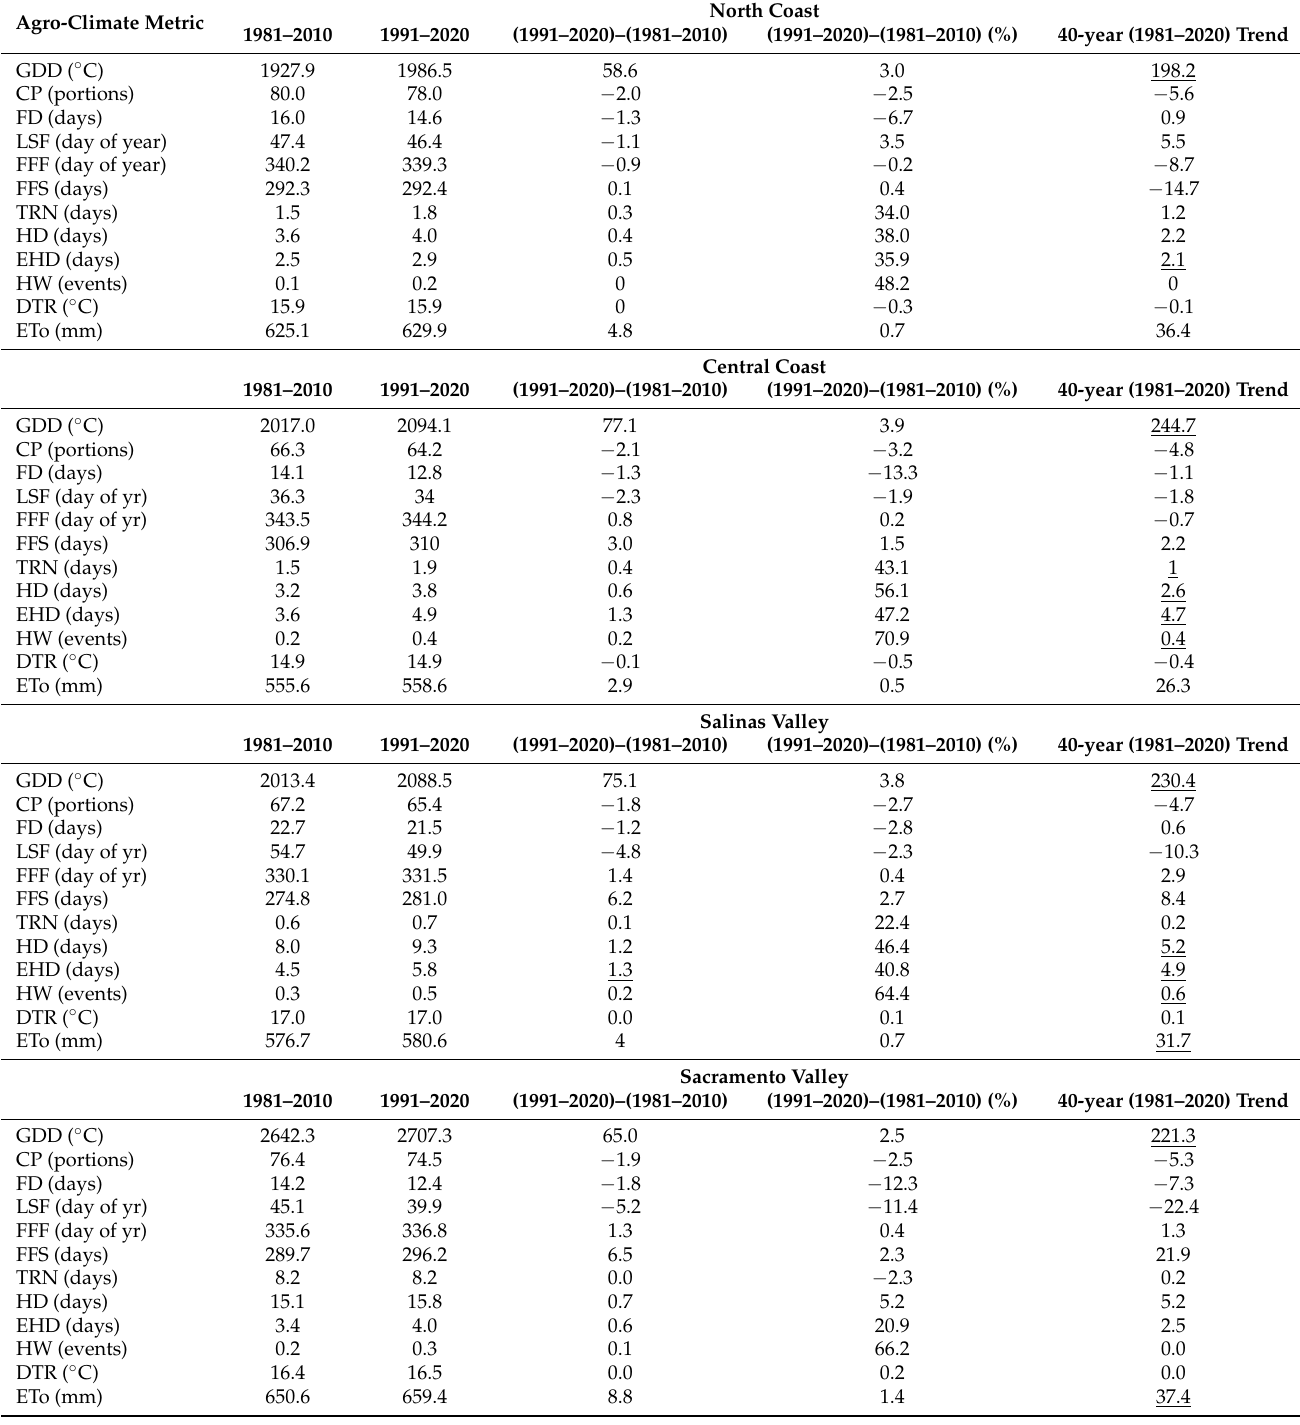
Table 3. Agroclimate metrics over crop locations in each agriculture region for 1981–2010, 1991–2020, the absolute and relative difference between 1981–2010 and 1991–2020, and the 40-year trend over the 1981–2020 period. Underlined values indicate statistical significance in difference or